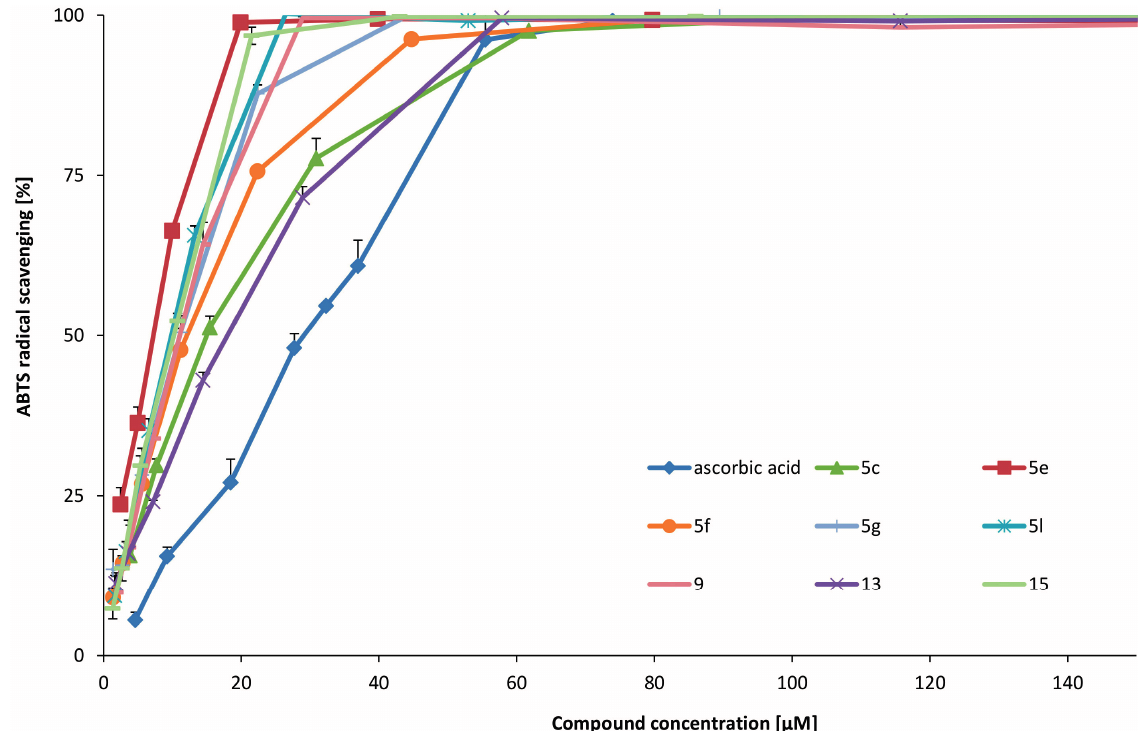
Figure 2. ABTS ·+ scavenging of the most active